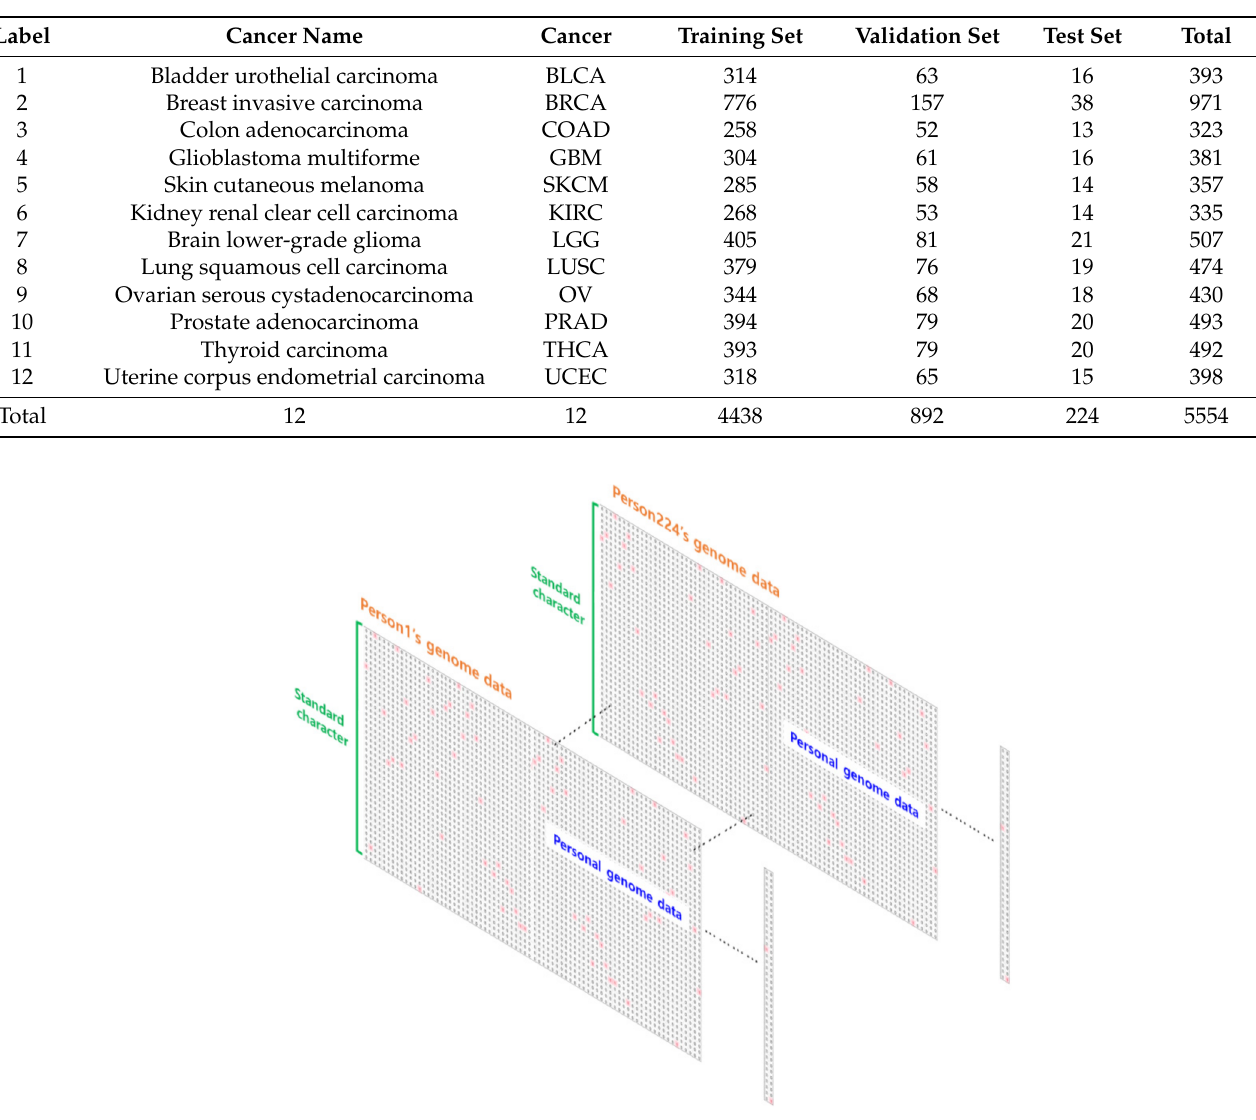
Table 1. Name and number of dataset for 12 cancers.